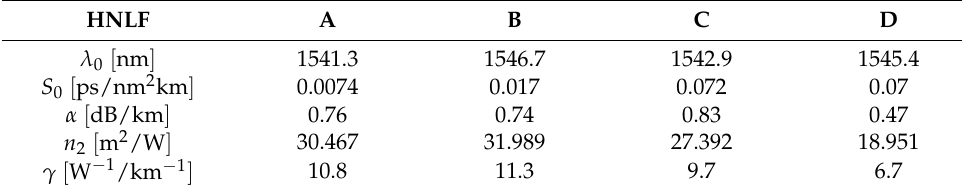
Table 2. Four types of highly nonlinear fiber (HNLF) are considered for